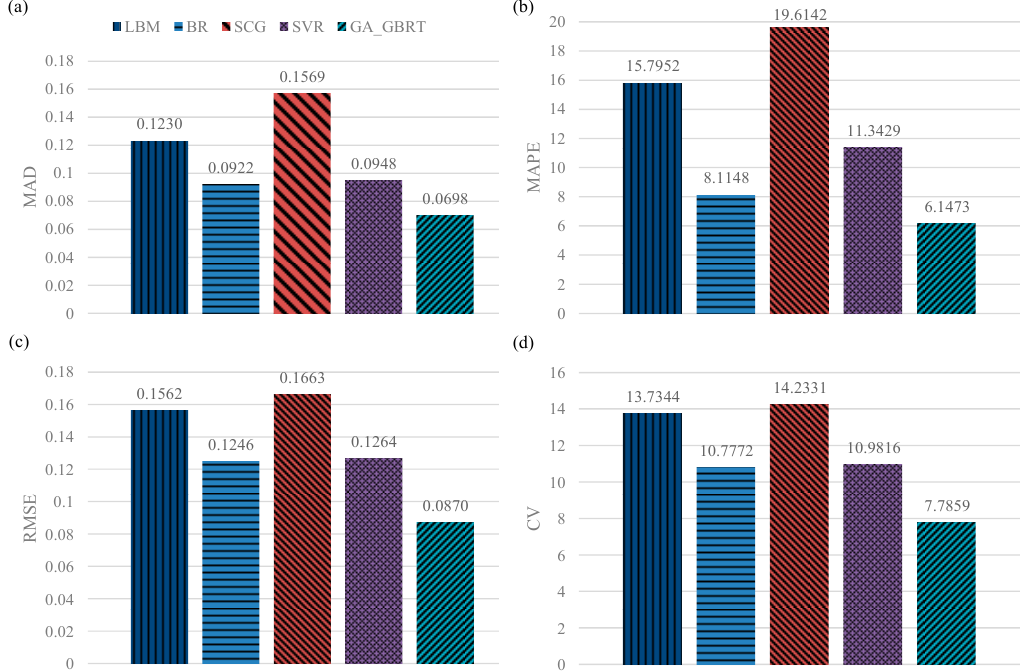
Figure 13. Performance comparison of five surface roughness prediction models: ( a ) MAD; ( b ) MAPE; ( c ) RMSE; ( d ) CV. Table 6. Comparison of literature prediction indicators.